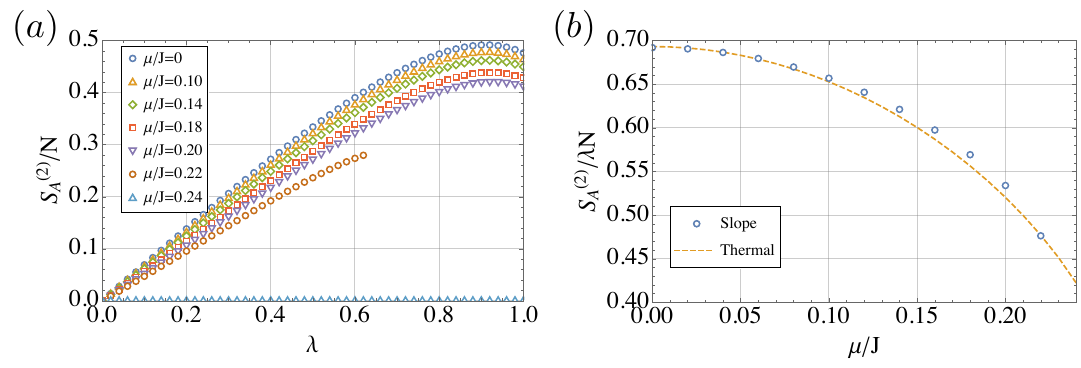
( 2 ) / N for different µ/ J with β J = 50 and q = 4. Figure 4: (a). Subsystem entropy S A ( 2 ) / N at small λ for different µ/ J with β J = 50 and q = 4. (b).The slope of S A